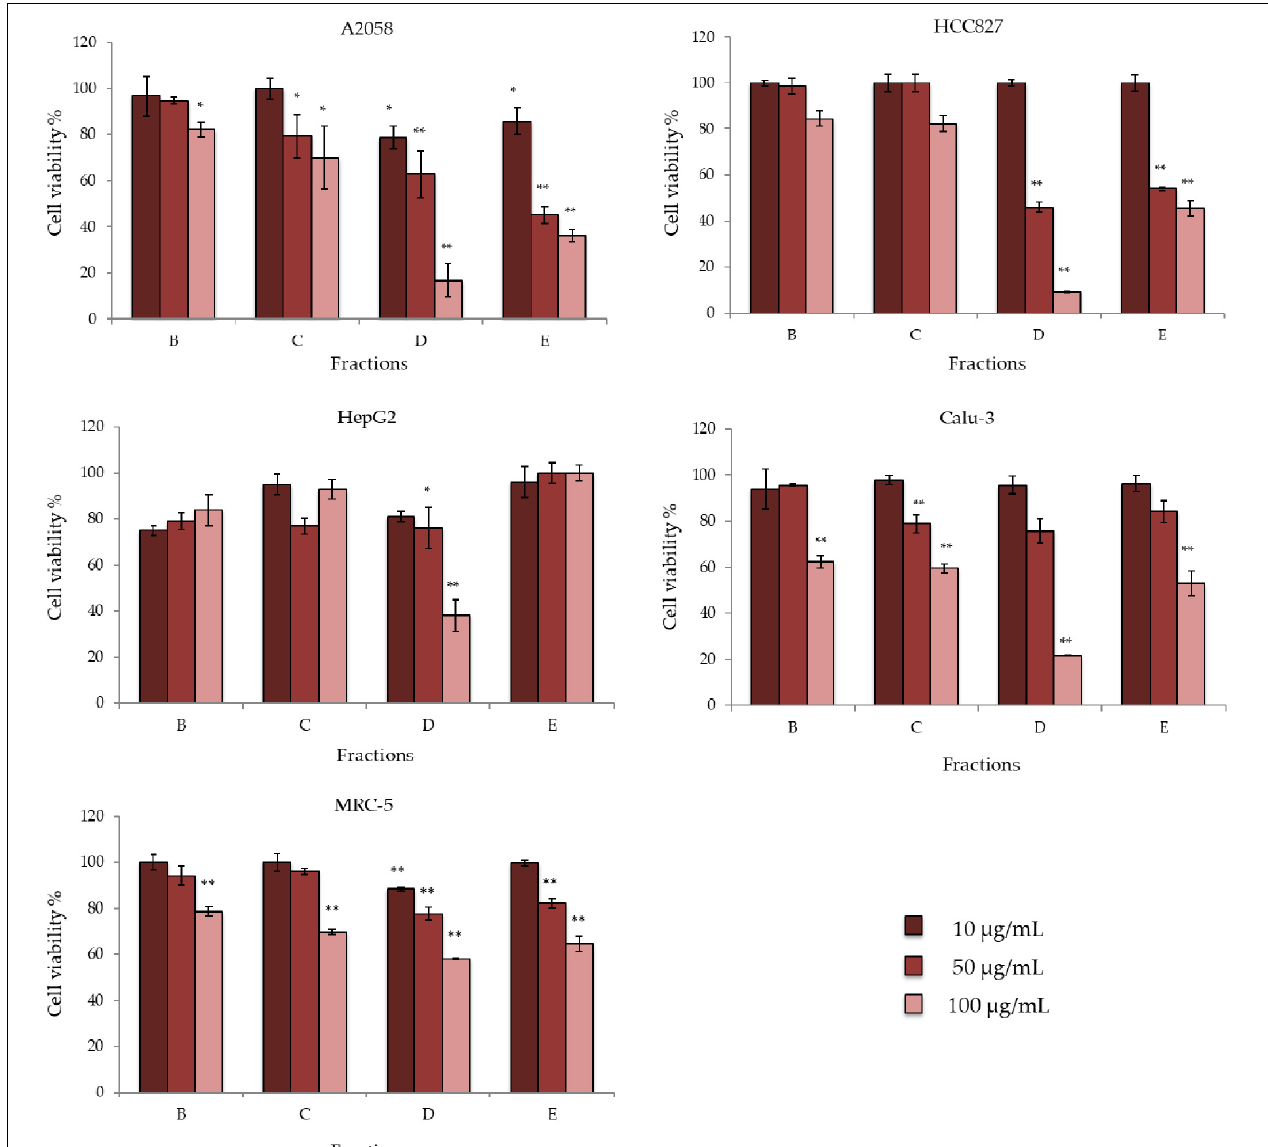
FIGURE 2 | Antiproliferative effects of Dunaliella tertiolecta fractions on A2058, HepG2, HCC827, Calu-3, and MRC-5 cell lines. Results are expressed as percentage of cell survival after 72 h exposure ( n = 3). Cell growth was expressed as the percentage of cell viability with respect to the vehicle (DMSO) for each concentration. ∗∗ p < 0.01, ∗ p < 0.05 vs. untreated